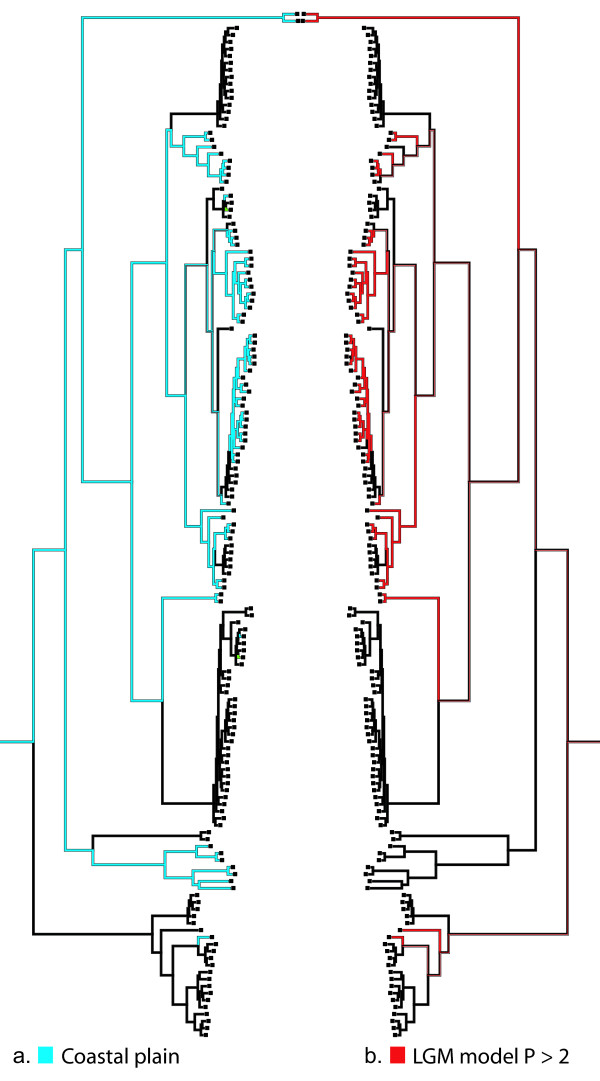
Mirrored character state optimizations of coastal plain and paleo-presence threshold matrices onto the mtDNA haplotype phylogeny using a parsimony character reconstruction method. (a) Optimization of the coastal plain (light blue branches) and "montane" (black branches) characters states. (b) Red branches indicate habitat suitability above the lowest point threshold (P = 0.2) derived from the niche-based paleodistribution model (values extracted from analysis illustrated in Figure 6b); black branches show optimization of character state that represents values where P < 0.2 (i.e., Narceus not expected to have occurred in these areas during the Pleistocene glaciation.